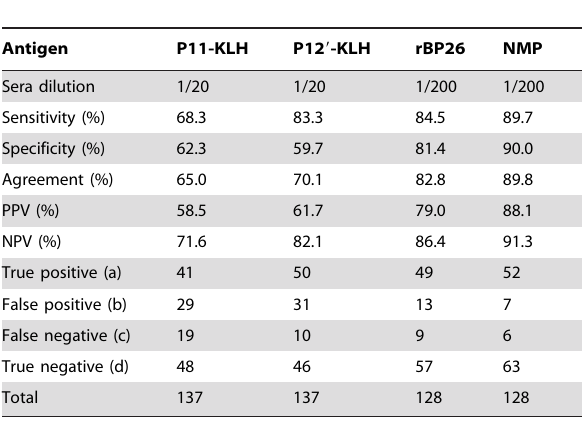
Figure 3. Reactivity of sheep sera to linear epitope peptides, rBP26 and NMP of B.melitensis in ELISAs. The receiver operating characteristic (ROC) curves were plotted using the SPSS software version 13.0. According to optimal cutoff values by the highest sum of sensitivity and specificity, the areas under ROC curves for antibody responses in sheep sera by ELISAs were compared with the results by a combination of two standard serological tests. P value was calculated for comparing the differences between areas under ROC curve and reference (0.5) by the Kolmogorov-Smirnov Z analysis. doi:10.1371/journal.pone.0034246.g003 Table 3. Evaluation for reactivity of peptides and proteins of B. melitensis to sheep sera in